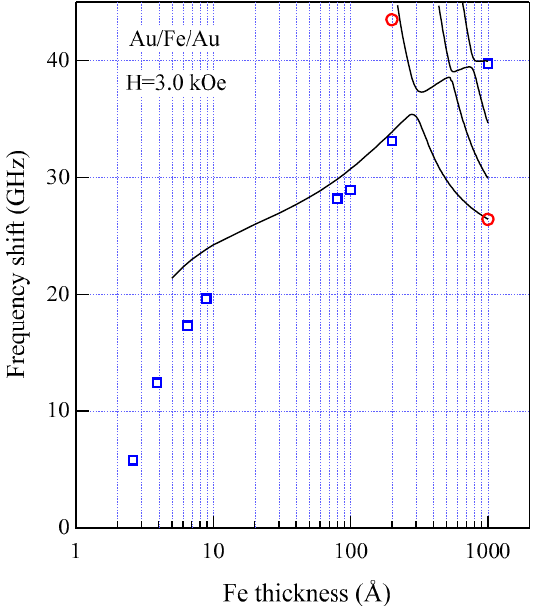
Figure 18. SW frequencies ( □ for the DE mode, ○ for the n = 1 SSW mode) observed from the SWs propagating along the [110] direction on the epitaxial (001) thin Fe films and Fe wedge as a function of the Fe thickness. The solid lines are the calculated SW frequencies, and the results above d ≥ 1 nm are already shown in Figure 11. Although the MAE and the effective demagnetization factor were included in the calculation, the surface perpendicular anisotropy term was not included [61]. The broken lines are just for eye.